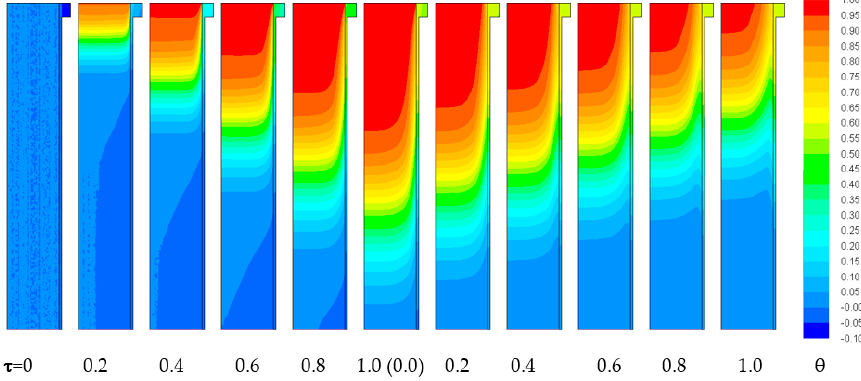
Figure 6. Fluid temperature contour plots in the porous bed.